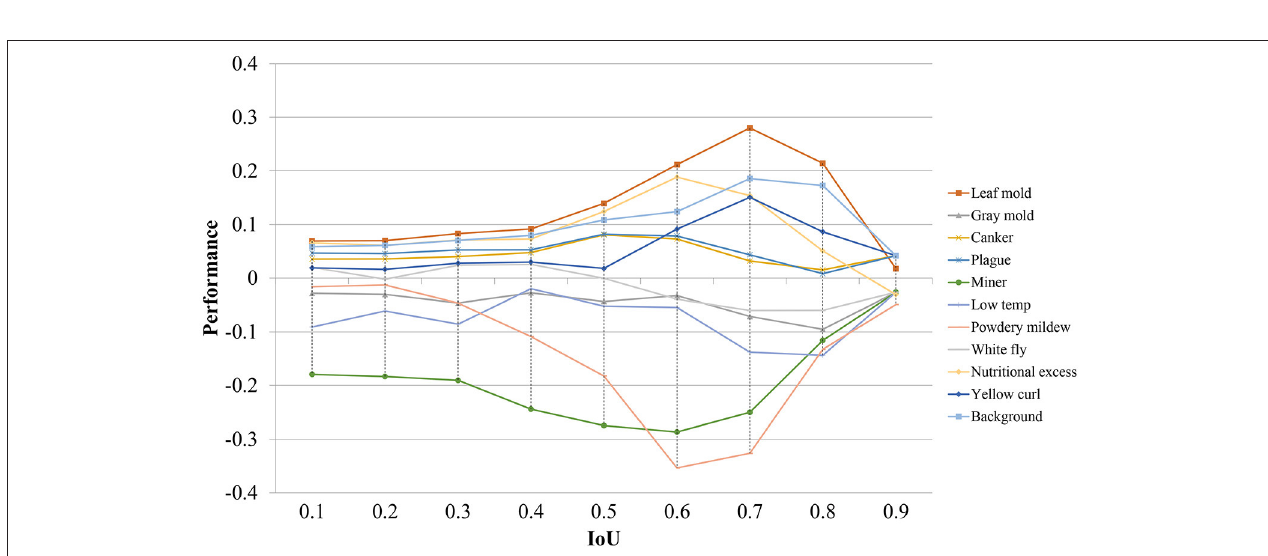
FIGURE 7 | Performance differences of all detected classes in terms of their average precision using different IoU threshold values. Note that some classes experience a positive performance, while others show a negative value.